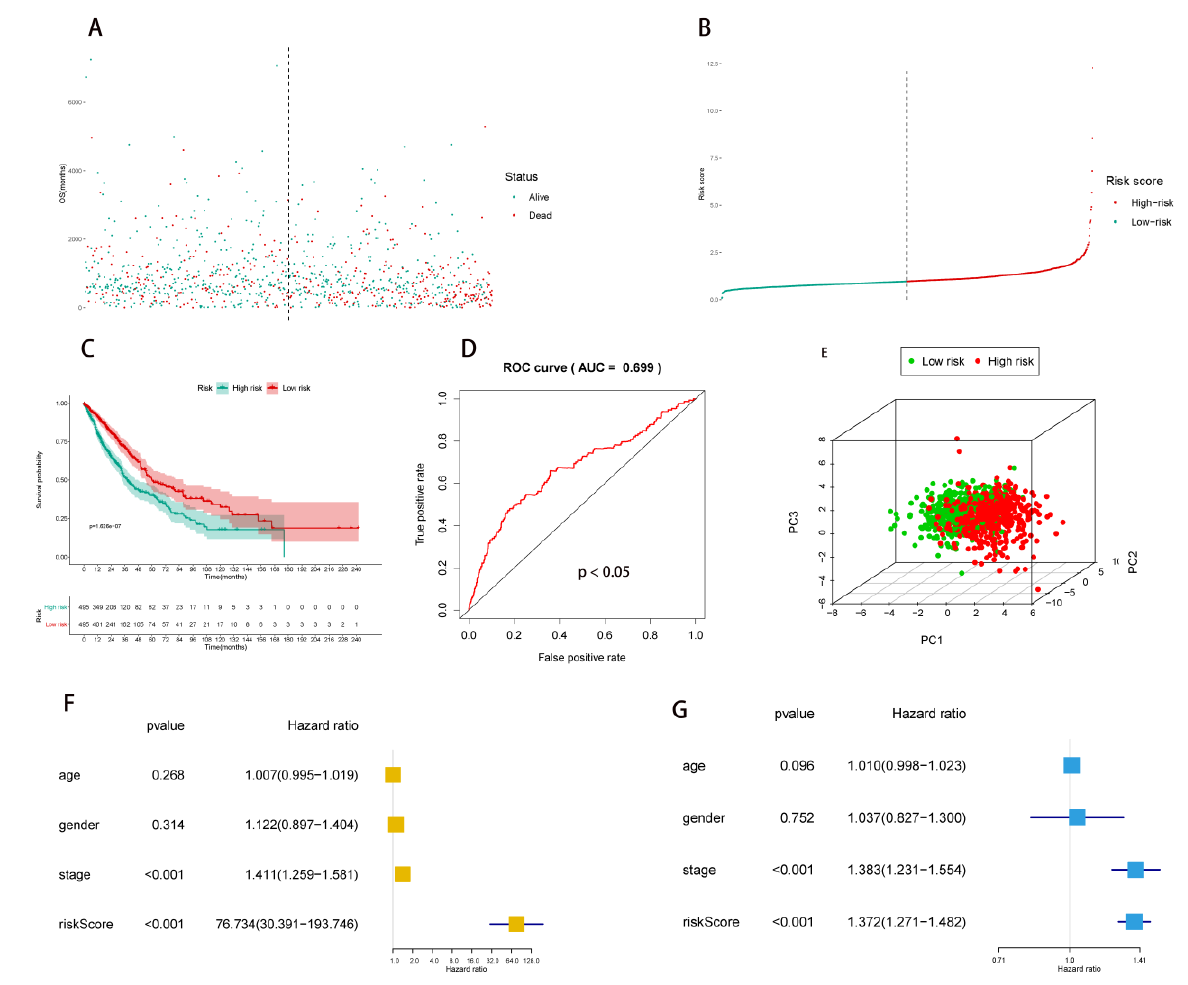
Figure 3. Independent prognosis analysis. RS was calculated by 24 PDEEs integration multivariate Cox model. ( A , B ) The scatter plot and line plot illustrated the distribution of RS among all NSCLC patients. ( C ) The ROC curve indicated that the multivariate Cox regression model was of good predictive power (AUC = 0.699). ( D ) The Kaplan–Meier curve showed that RS had prognostic value for NSCLC patients ( p < 0.05), red line and green line represented low-risk group and high-risk group, respectively. ( E ) The distribution of low-risk and high-risk groups in PC1, PC2 and PC3, red plots represented high-risk groups and green plots represented low risk groups, the proportion of variance for PC1, PC2 and PC3 were 0.141, 0.087 and 0.074, respectively, the cumulative proportion was 0.302. ( F , G ) The univariate (HR = 76.734, 95% CI (30.391–193.746), p < 0.001) and multivariate (HR = 1.372, 95% CI (1.271–1.482), p < 0.001) Cox regression analysis for RS defined RS as an independent prognostic factor for NSCLC patients. The multivariate Cox regression model was corrected by age, gender and stage. RS, risk score; PDEEs, prognostic differentially expressed eRNAs; eRNAs, enhancer RNAs; ROC, receiver operator characteristic; AUC, area under curve; NSCLC, non-small cell lung cancer; HR, hazard